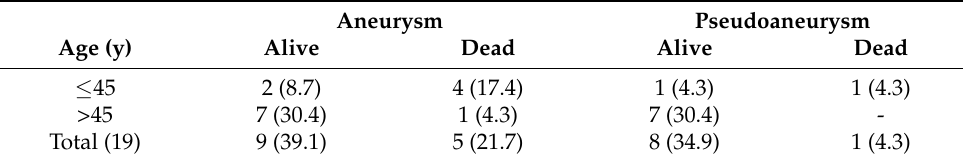
Table 5. Subjects above and below 45 years of age were identified, and for each one, aneurysm or pseudoaneurysm affection was studied, determinating death or not. The percentage was calculated based on the total number of male individuals [23].